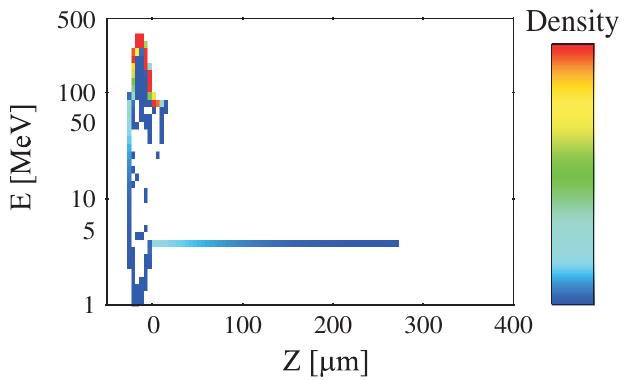
FIG. 8. (Color) Density plot of the position and energy of the electrons at the exit of the plasma channel in the bunch center of mass system (as in Fig. 1) for a bunch with an initial bunch length of 1250 fs in the accelerator scheme. The center of the original bunch has reached the desired maximum energy at the exit of the plasma channel, but the front part of the bunch has not been trapped and compressed by the plasma wave yet and still retains it original energy and length.